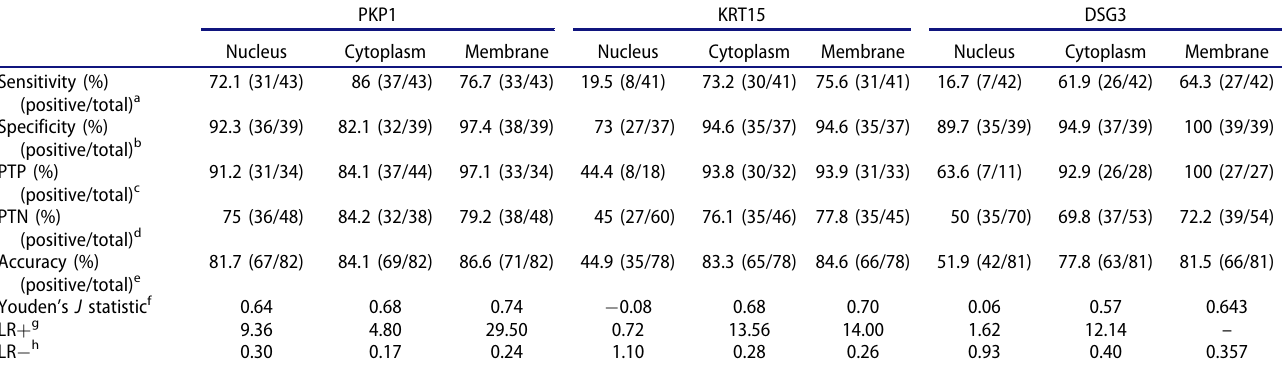
Table 3. Expression of novel SCC markers. Sensitivity, specificity, percentage of true positives and percentage of true negatives, accuracy, Youden ’ s J statistic, and positive and negative likelihood ratio values for PKP1, KRT15, and DSG3 staining according to their nuclear, cytoplasmic, or membranous localization. PKP1 KRT15 DSG3 Nucleus Cytoplasm Membrane Nucleus Membrane Nucleus Cytoplasm Membrane